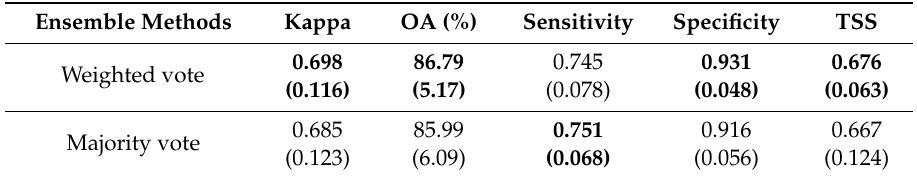
Figure A1. Changes of Kappa values of different algorithms using the variables with different combinations under 12 monthly single-scene analyses. The Bands includes Blue, Green, Red, and NIR; the VIs includes NDVI, RVI, DVI, SAVI, and EVI; and the PCA includes the first three principal components of PCA (PC1, PC2, and PC3). Table A1. Mean and standard deviation of overall accuracy, Kappa coefficient, sensitivity, and specificity of the two ensemble methods (i.e., weighted vote and majority vote) in Scenarios 1 and 2. Values in parentheses are standard deviations. The best result of each accuracy metrics is bolded.